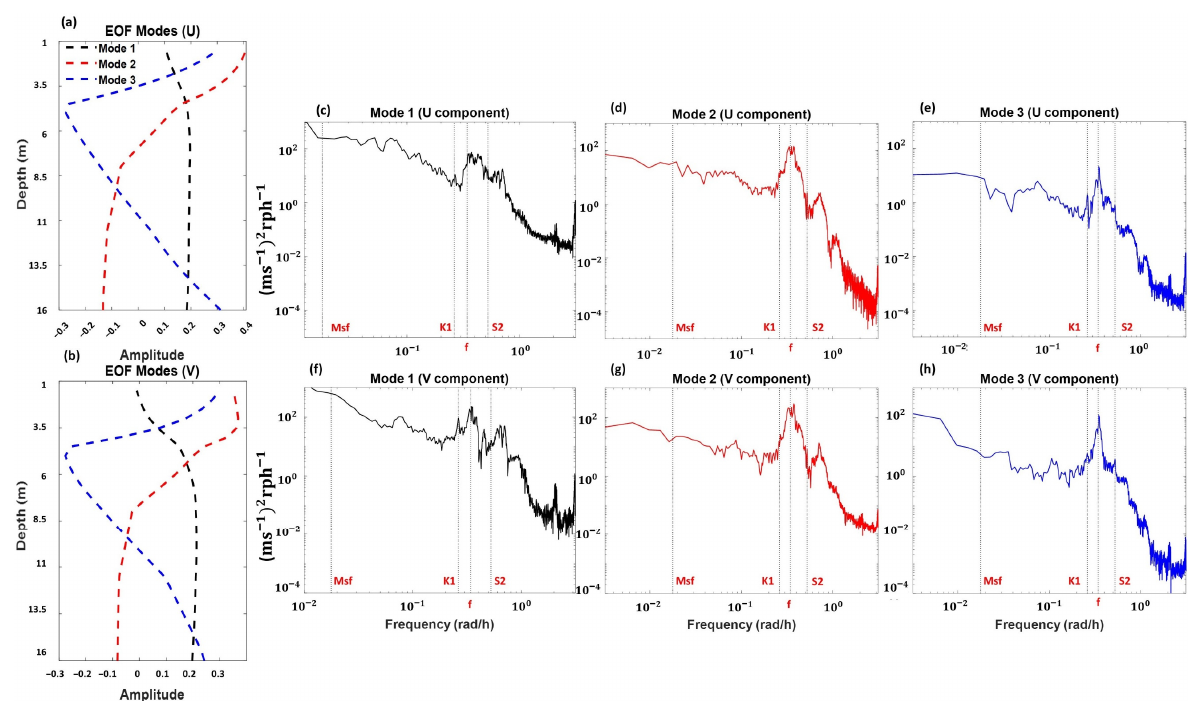
Figure 13. Spatial pattern for the first 3 EOF (black line for EOF Mode 1; red line for EOF Mode 2; blue line for EOF Mode 3) modes for the zonal ( a ) and meridional ( b ) components simulated by CROM in the BN area. Frequency spectra ( c – h ) of the principal component associated with the 3 modes.